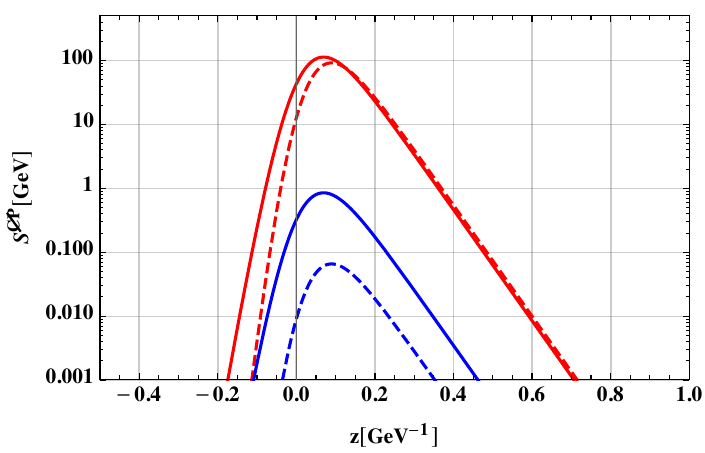
Figure 3 . z -dependence of the LO (solid lines) and NLO (dashed lines) source terms for a quark with ~ y f = 0 : 1 (red) and ~ y f = 1 (blue). We use the bubble wall pro(cid:12)le ’ b ( z ) = ’ N = 2(1+tanh z=L w ), with L w = 10 =T ’ N = T N = 100 GeV and j f f j (cid:25) ~ y f ’ b . CP-violation stems from a dimension-6 operator as in refs. [13, 16, 36, 37], giving (cid:14) = 3~ y 2 with respect to z , we take (cid:3) = 1 TeV and bubble wall velocity v w = 0 :